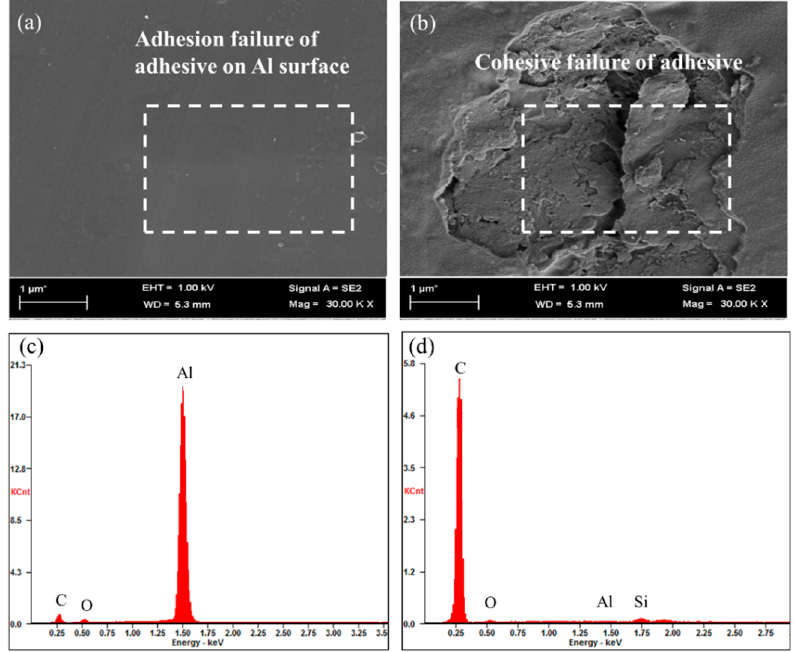
Figure 10. SEM images and EDX results of the Al surfaces of CPP/EPDM-B-15/Al foil and CPP/EPDM-B-15/APTES-treated Al foil laminates after peel test. The peel test was conducted after tempering of the laminates at 80 ◦ C for 1 day: ( a ) Al surface of CPP/EPDM-B-15/Al foil; ( b ) APTES-treated Al foil surface of CPP/EPDM-B-15/APTES-treated Al foil; ( c , d ) EDX results in the area assigned with white dotted line in ( a ) and ( b ) respectively.